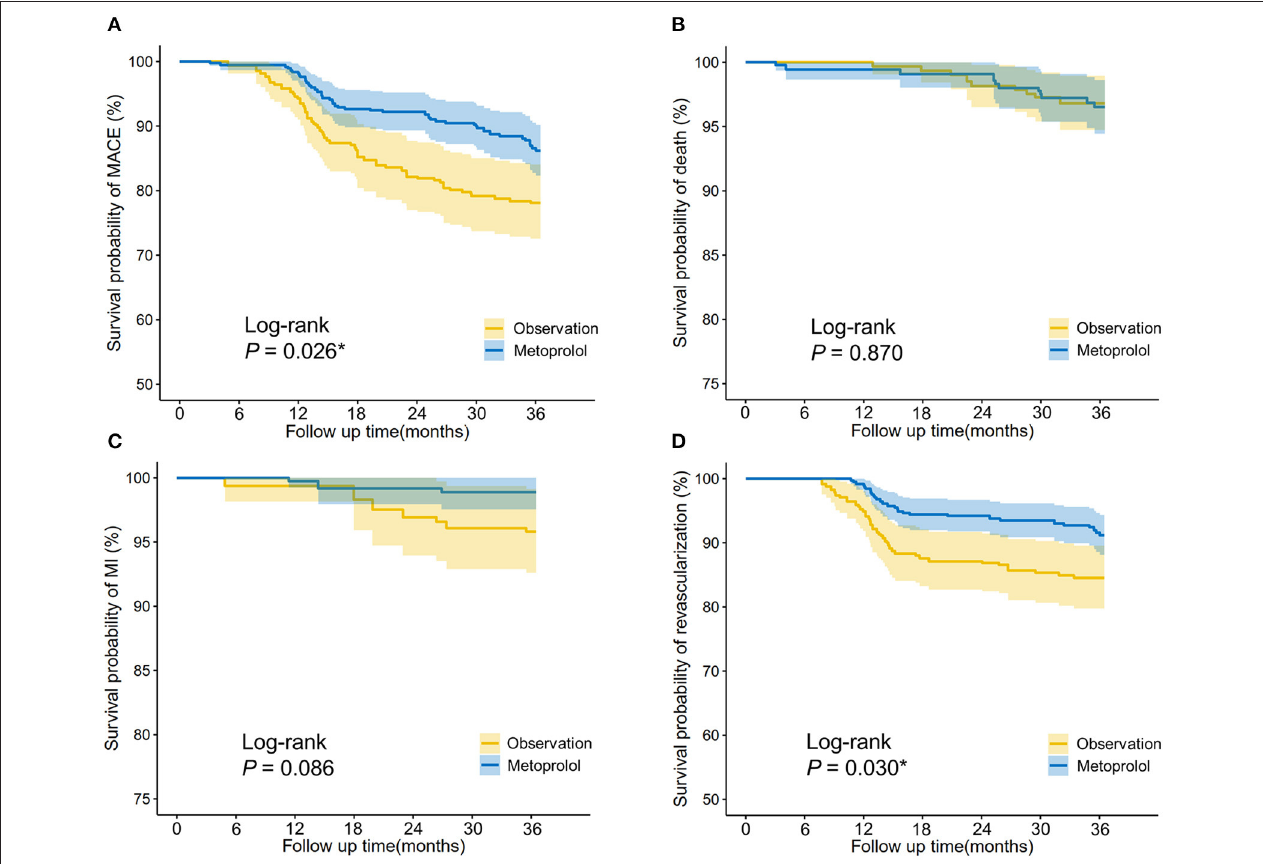
FIGURE 3 | IPTW-adjusted Kaplan-Meier analysis of (A) major adverse cardiovascular events (MACEs), (B) cardiac death, (C) myocardial infarction, and (D) revascularization in patients who received metoprolol vs. observation after PCI-related PMI. The survival curves were indicated by solid lines and 95% CIs by shaded areas. Log-rank P -value was shown. * P <